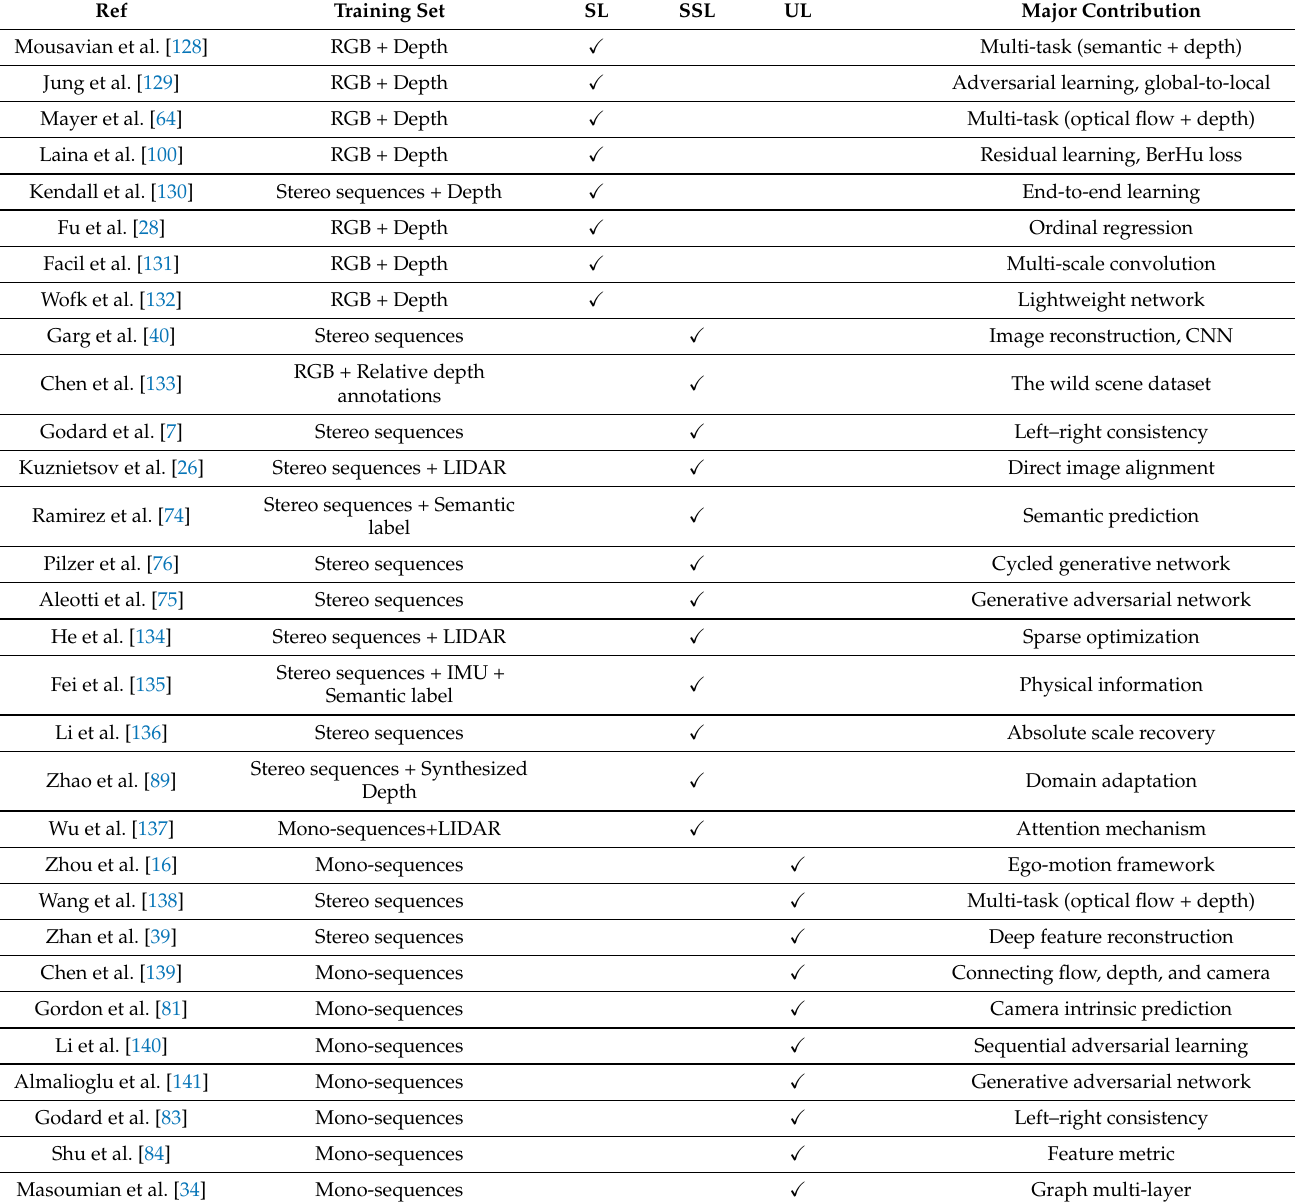
Table 6 aims to represent comprehensive information about the existing procedures based on their training data, supervised signals, and contributions. Table 6. Comprehensive information about the applied procedures in the deep learning of